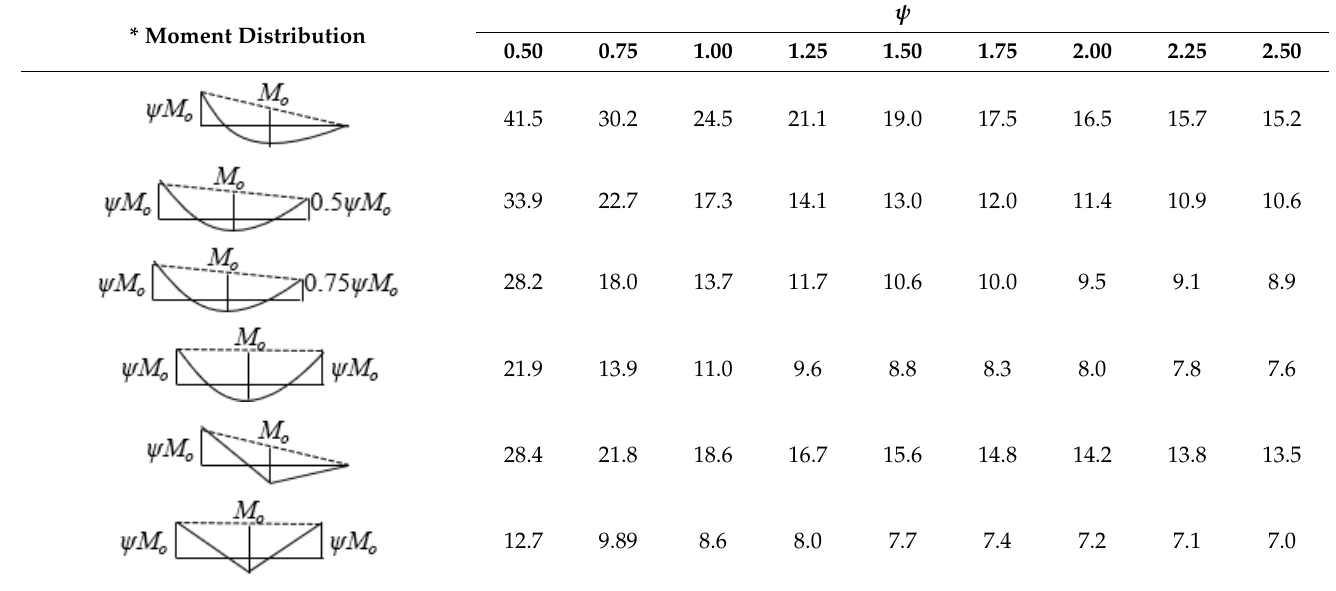
Table 4. C dist coefficient for continuous beams without loading on the analyzed span ( L ). Adapted from ABNT NBR 8800:2008 [108] . * Moment Distribution